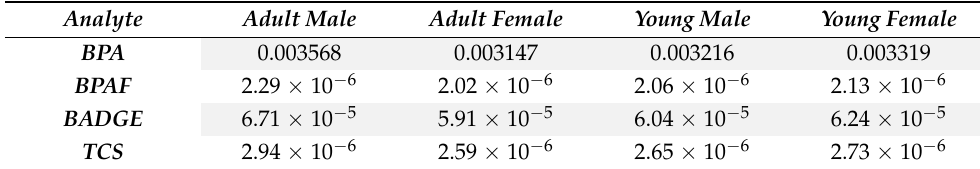
Table 6. Calculated EDI/TDI ratio for adult and young, male, and female, based on TDI EFSA values